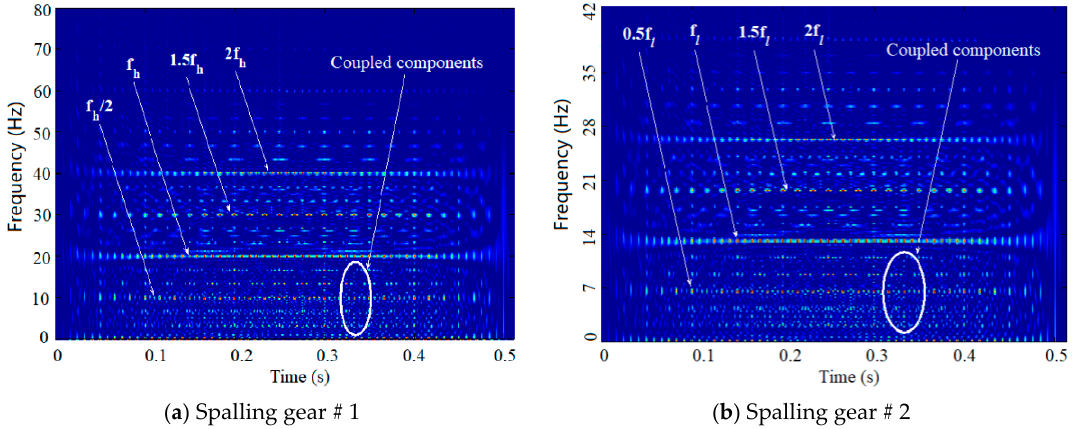
Figure 7. Two independent sources separated by nonlinear ICA with spalling gear #1 and worn gear #2.